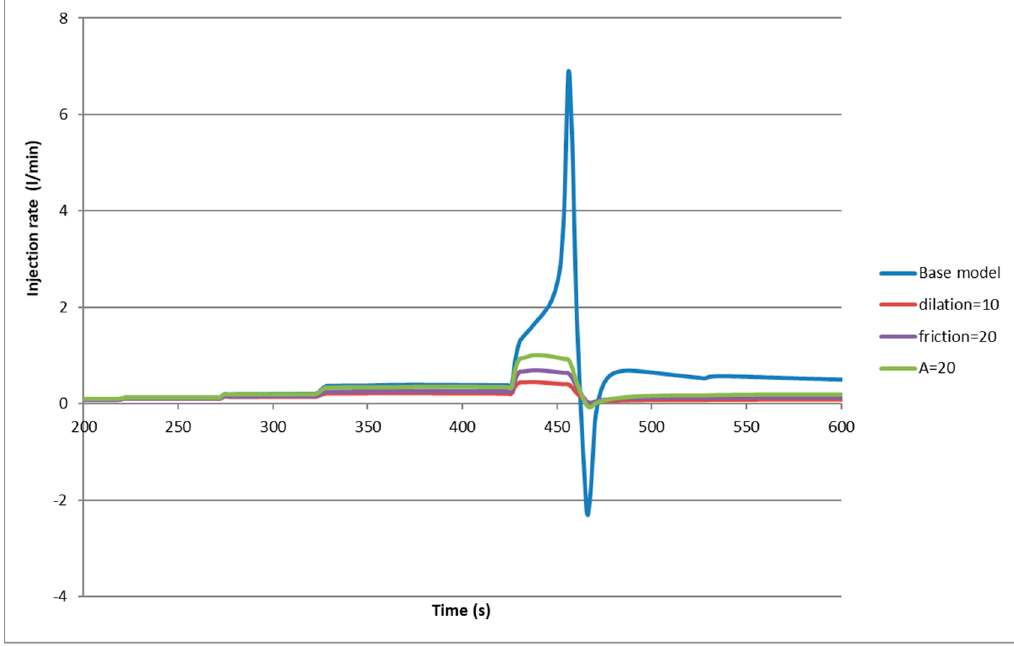
Figure 8. Comparison of injection rate for different fault shear strength parameters.